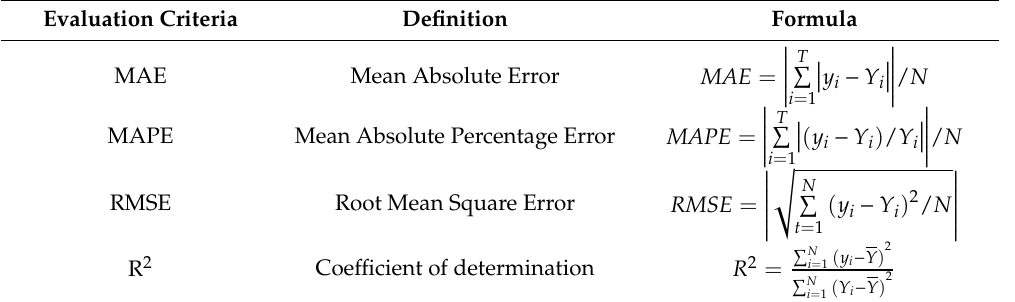
Table 2. Specific instruction for each